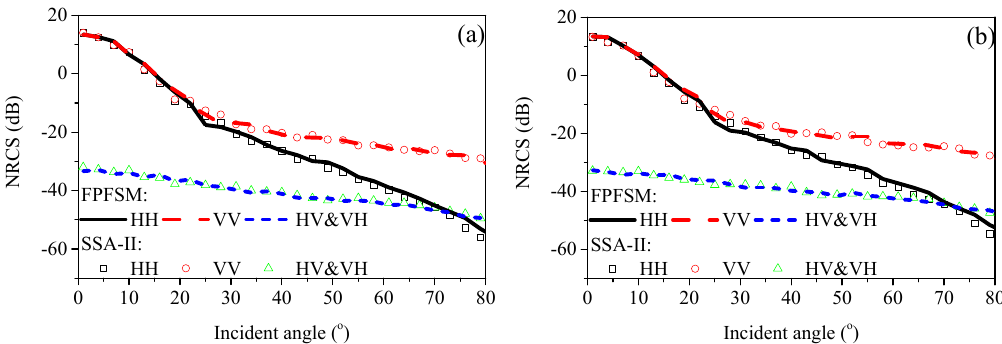
Figure 7. Comparison of the NRCS results calculated by FPFSM, SSA-II and real SAR data at C-band. ( a ) Monostatic configuration; ( b ) Forward–backward configuration.